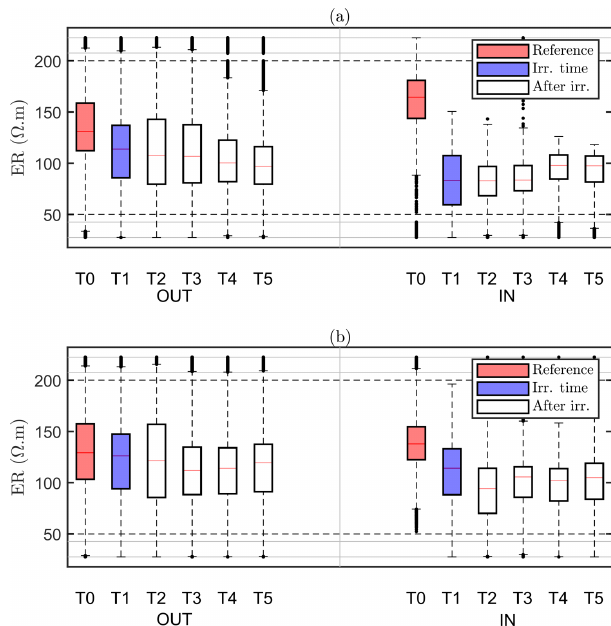
Figure 8. Boxplot distribution of ER time variations observed on plant A (a) and plant B (b) for the values selected outside (OUT, left part) and inside (IN, right part) of the region defined by the F 1 best-fit sources (see Fig. 6a – T 0 ). The central mark indicates the median; the bottom and top edges of the box indicate the 25th and 75th percentiles of the ER data, respectively. The whiskers extend to the most extreme data points (black dots) considered outliers. Each box corresponds to a given time step (see Table 1), indicated in the x